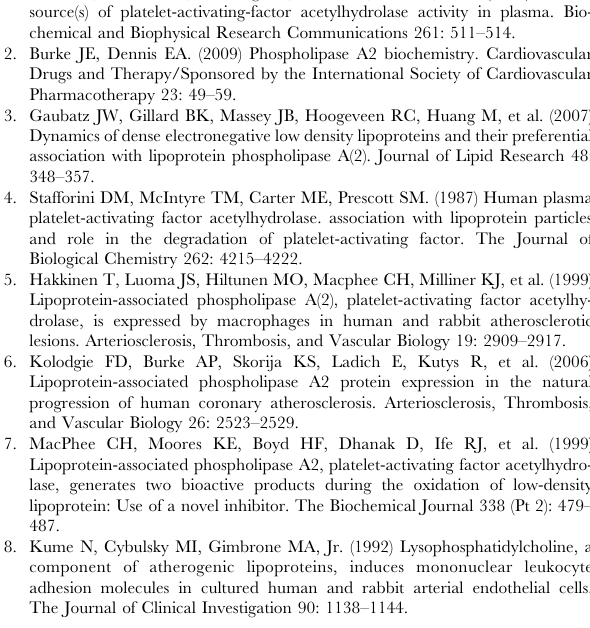
Figure S1 Lp-PLA2 Z-scores Bland and Altman plot. Increasing Lp-PLA2 mass z-score is associated with more negative